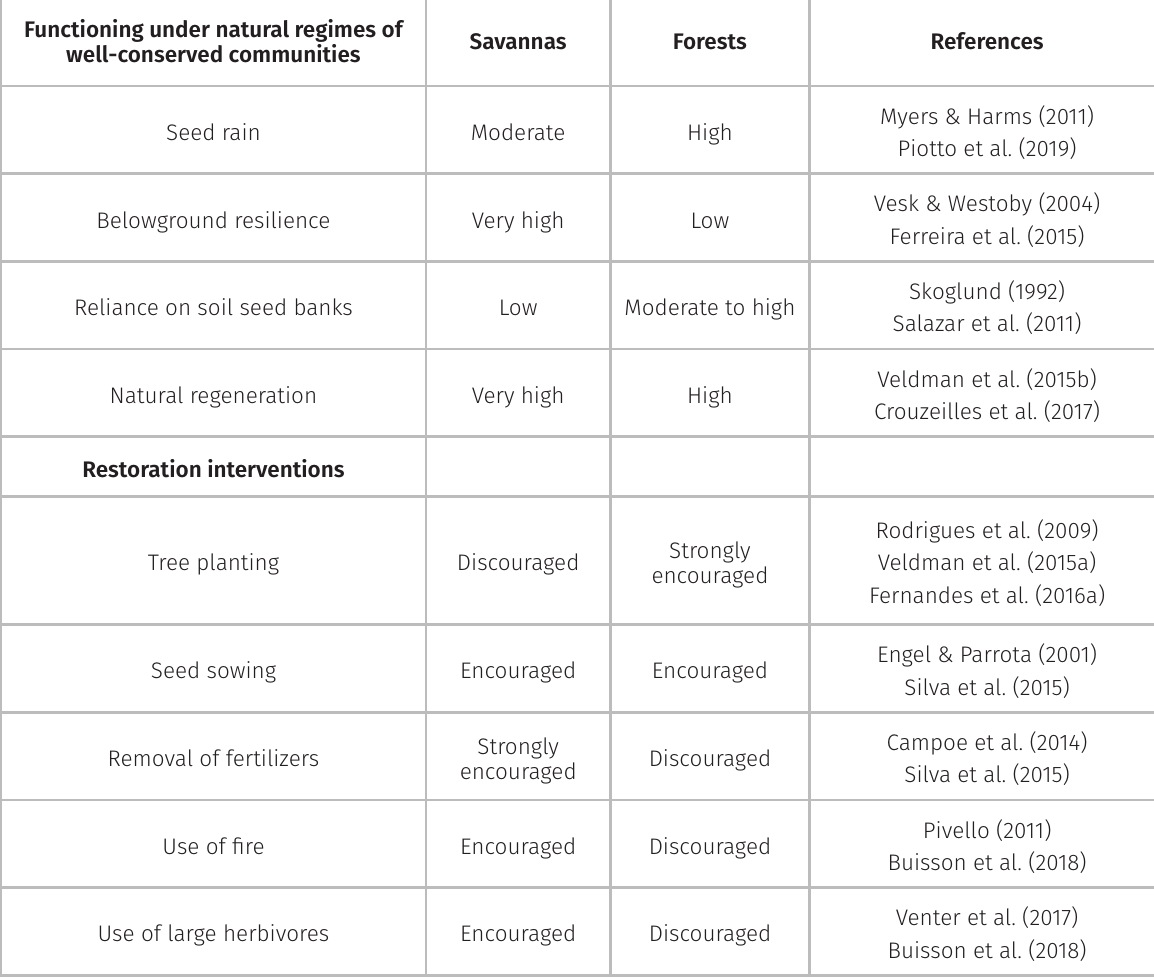
Table I. Ecological information on intact savanna and forest ecossystems and restoration interventions recommended to restore degraded areas of each ecossystem. Functioning under natural regimes of well-conserved